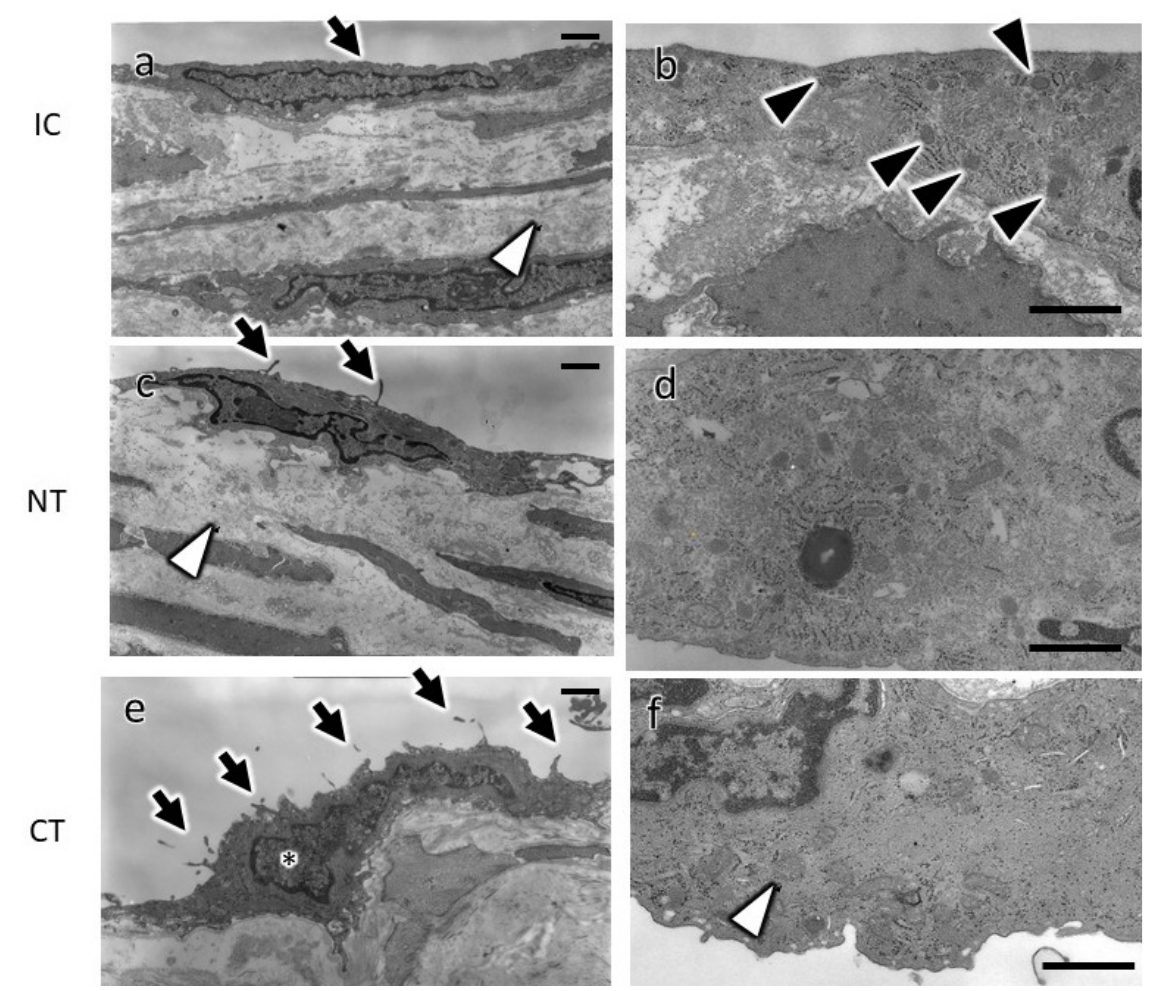
Fig. 3 - Transmission electron microscopy images of the saphenous vein graft (SVG) tissues prepared by different harvesting methods (no-touch [NT] and conventional [CT]) and the intact control (IC). The images show the IC vein (a, b), NT SVG (c, d), and CT SVG (e, f) at low (a, c, e) and high (b, d, f) magnification. In IC (a), endothelial cells had smooth and thin shapes and covered the entire luminal surface of the saphenous vein (a, arrows). Few microvilli and small vesicles were observed in the endothelial cells (a, arrows). The collagen fibers kept an orderly arrangement in the subendothelial matrix (a, white arrowhead). In the cytoplasm of endothelial cells, the mitochondria were rich, and their shapes were thin and long (b, arrowheads). In NT (c, d), the morphology of the saphenous vein was mostly preserved. The shape of many endothelial cells was similar to that in IC. However, some endothelial cells in NT showed a slight change in their surfaces, characterized by microvilli formation (c, arrows). A slight edematous change was observed in the subendothelial matrix in NT, and (the bundles of collagen fibrils were less obvious in NT) arrangement became slightly crude compared with the IC (c, white arrowhead). In CT (e, f), mitochondria in the remaining endothelial cells were enlarged and swollen (f, white arrowhead). Furthermore, their nuclei appear larger (e, asterisk). Prominent microvilli and a decreased number of vesicles were observed on the surface of endothelial cells (e, arrows). Severe edematous changes were also observed in some areas of subendothelial tissue. Scale bars: 1